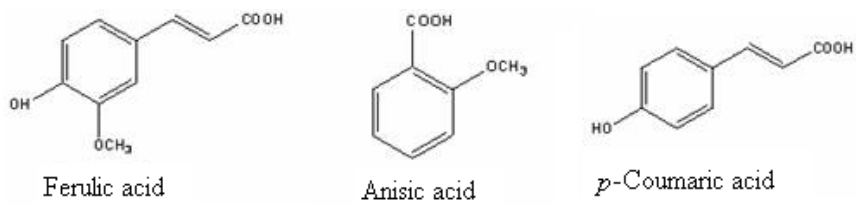
Figure 3. Three phenolic allelochemicals isolated from A. conyzoides rhizosphere soil [21].